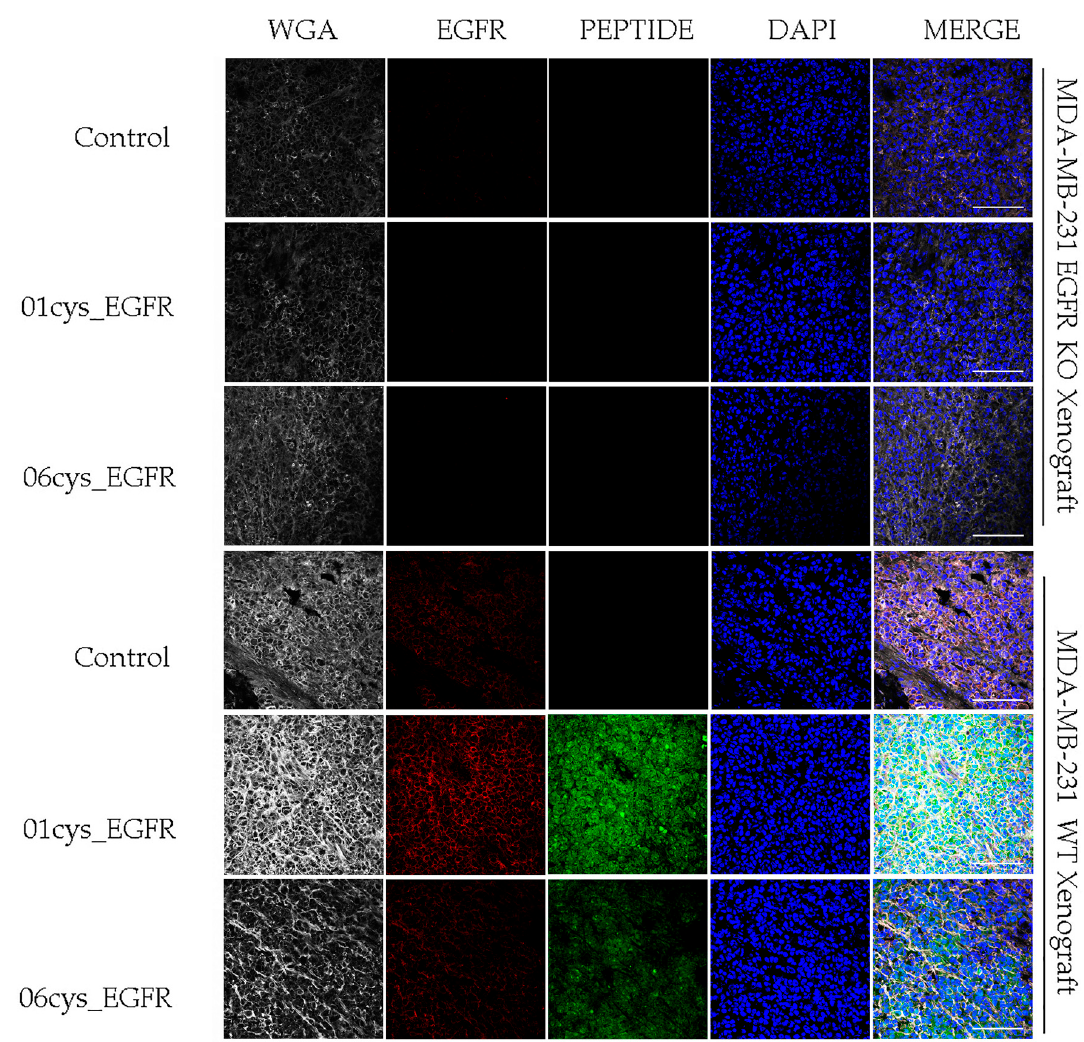
Figure 6. Immunostaining of MDA-MB-231 tumor xenografts with 01_cysEGFR and 06_cysEGFR peptides. Representative confocal images were acquired from MDA-MB-231 tumor xenograft tissue sections stained with anti-EGFR (red), the peptides irrelevant control, 01_cysEGFR and 06_cysEGFR (green), anti-WGA (white) and DAPI (blue). The merge of these channels confirmed the co-localization of EGFR and peptides on the cell membrane. Images were acquired at magnification 40 × using a confocal microscope (Leica TC-SP2 Confocal System, Leica Microsystem Srl, Milan, Italy). Scale bar = 100 µ m. Representative images of multiple serial sections are